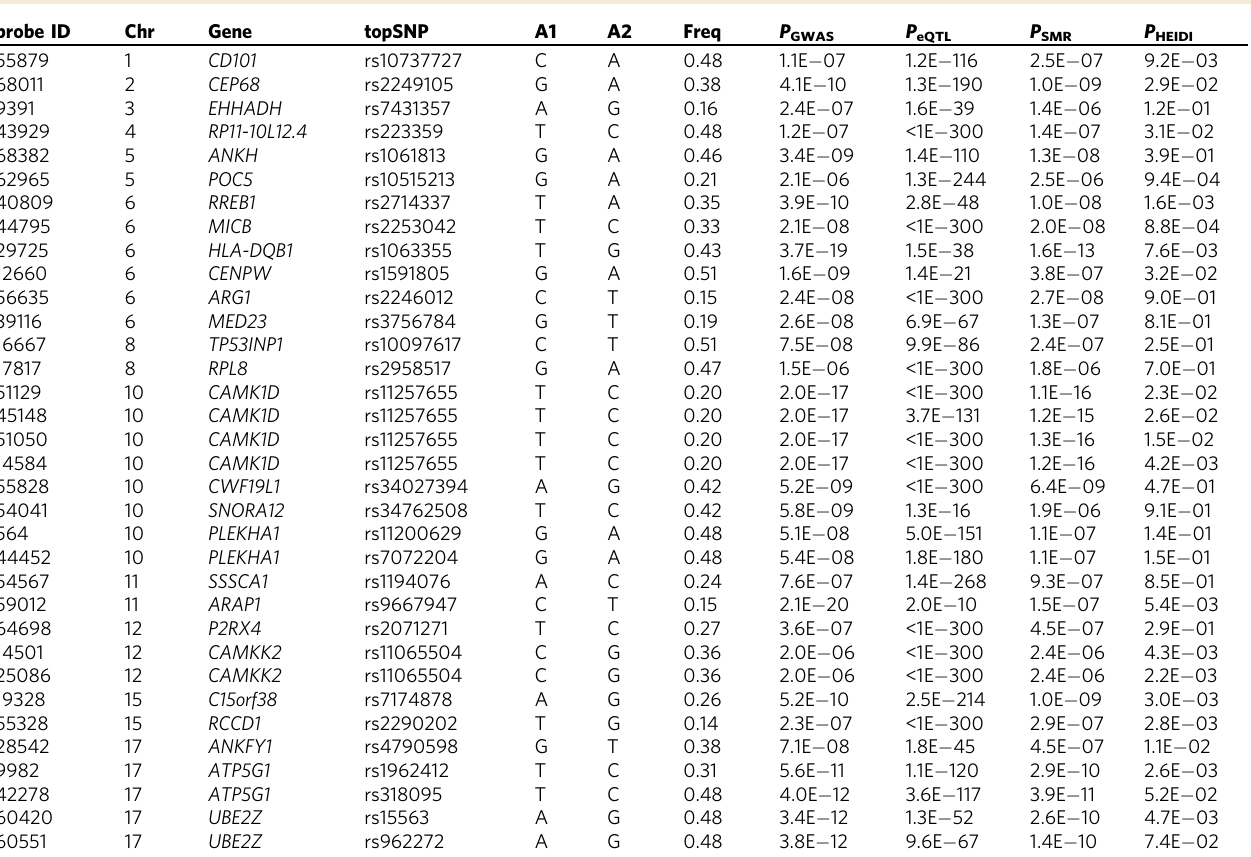
Table 2 Putative functional genes for T2D identi fi ed from the SMR analysis in eQTLGen probe